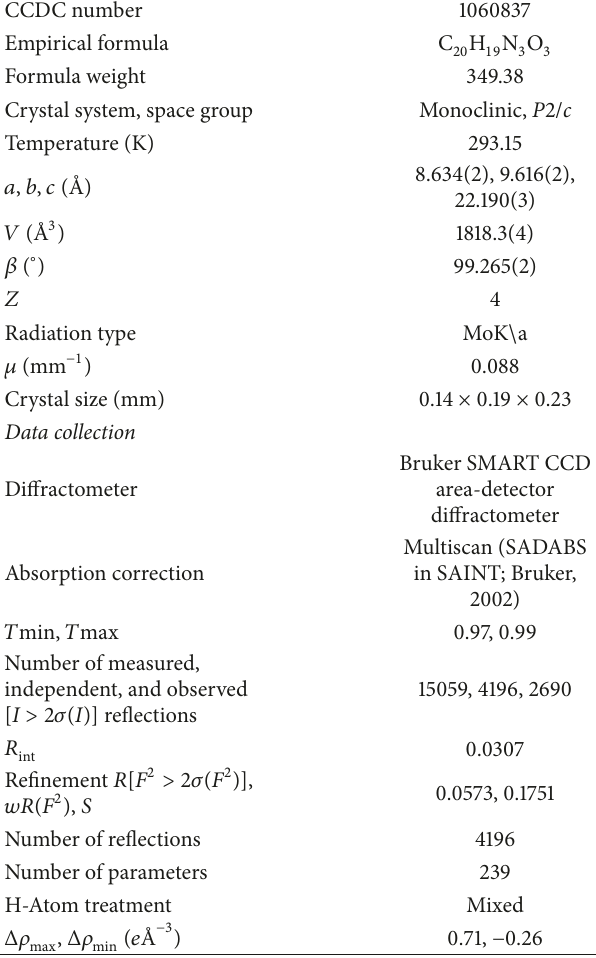
Table 1: Crystal data of title